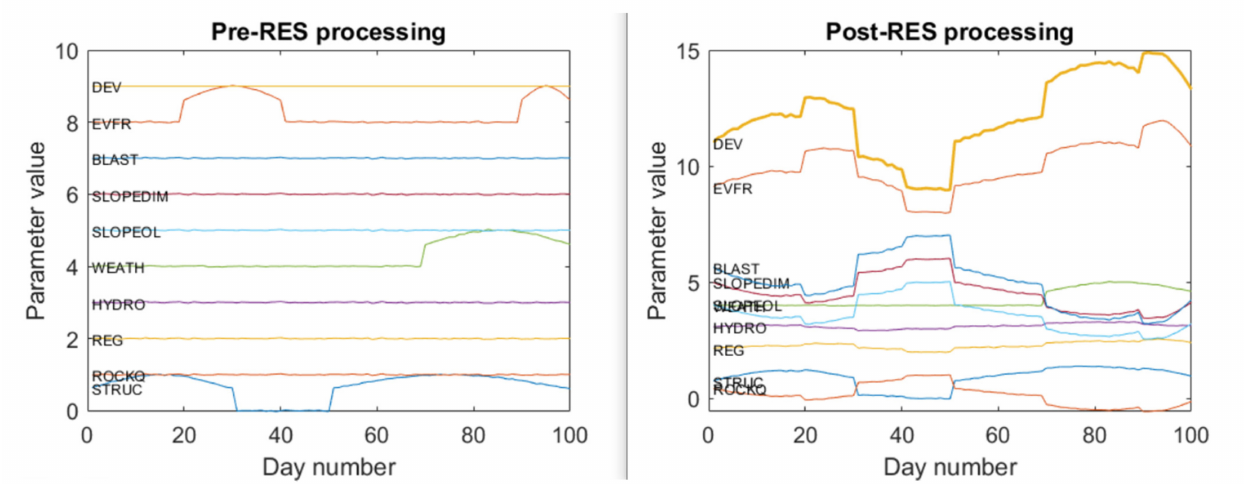
Figure 10. Simulated production data for the second 100 days (bold orange trace on right) and input RES parameters (non-bold traces) as a function of highwall strike distance. Traces have vertical offsets for clarity. The left figure shows inputs (uncoupled), and the right shows fully coupled outputs from the model.